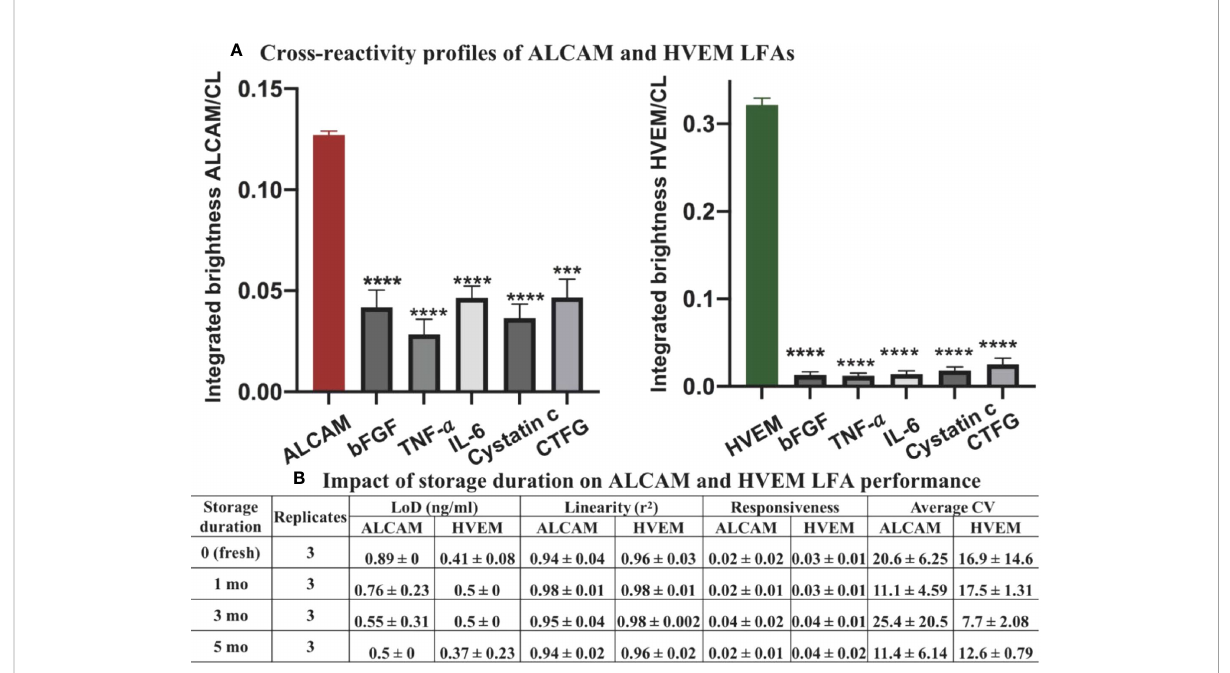
FIGURE 7 Cross-reactivity and LFA strip stability pro fi les of ALCAM LFA and HVEM LFA. (A) 1.5 ng/ml of ALCAM or HVEM (positive controls) or bFGF (150 ng/ml), TNF- a (130 pg/ml), IL-6 (120 pg/ml), cystatin c (125 ng/ml), and CTGF (100 ng/ml) were individually spiked to running buffer and assayed using the LFAs. Samples were loaded onto the ALCAM LFA (left) or HVEM LFA (right) in triplicates. ***p < 0.001, ****p < 0.0001 compared to the positive control, as determined using unpaired t-test. (B) The impact of storage duration on strip performance was next tested at room temperature over fi ve months, in triplicate. Three repeats of standard curves were constructed at each storage timepoint. No signi fi cant differences (one-way ANOVA) were observed among the groups in terms of LoD, responsiveness, linearity, and average CV. Linearity (r 2 ): goodness-of- fi t measure for linear regression model; responsiveness: the slope of the regression model (signal=slope*concentration + intercept); average CV: average of the coef fi cient of variance across three standard curves at each